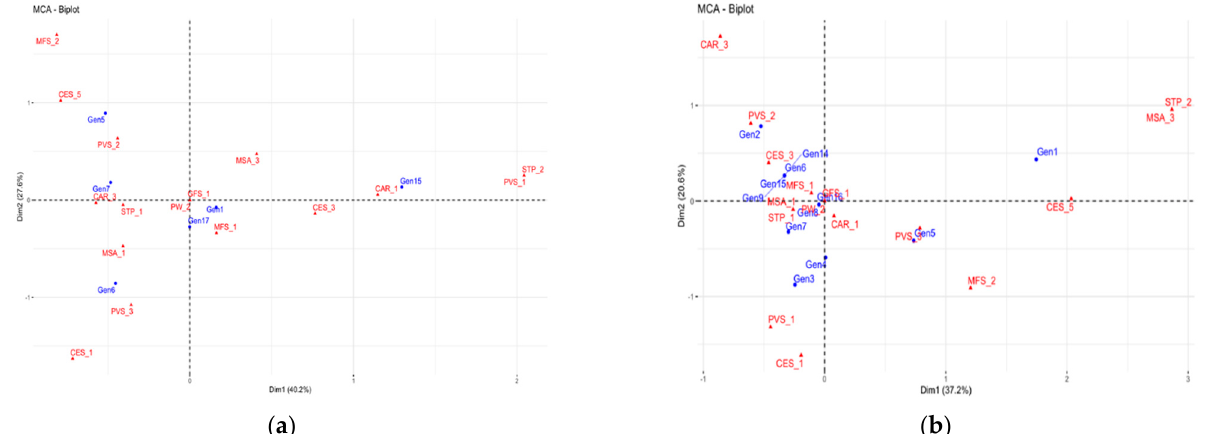
Figure 5. Multiple correspondence analysis of the contributions of qualitative variables in the systems: ( a ) open field and ( b ) under cover.